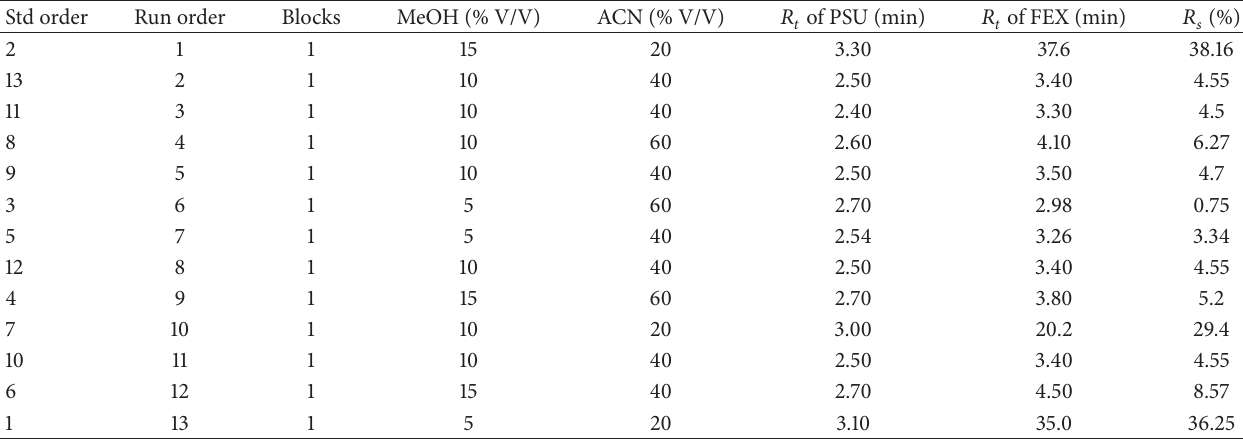
Table 3: CCD design matrix with two independent variables and observed responses.